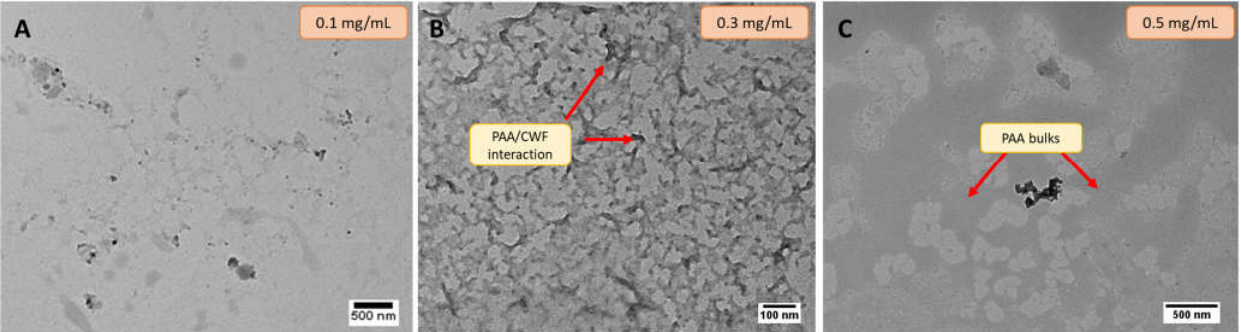
Figure 1. Transmission electron microscopy (TEM) micrographs of reactions carried out in aqueous medium using different concentrations of polyacrylic acid (PAA): ( A ) 0.1 mg/mL, ( B ) 0.3 mg/mL (red arrows indicate PAA bulks), ( C ) 0.5 mg/mL (red arrows indicate interaction between PAA and Schizochytrium sp.); maintaining constant the following parameters: Schizochytrium sp. cell wall fraction (CWF) (6 mg), ultrasound time (5 min), and amplitude (20%).